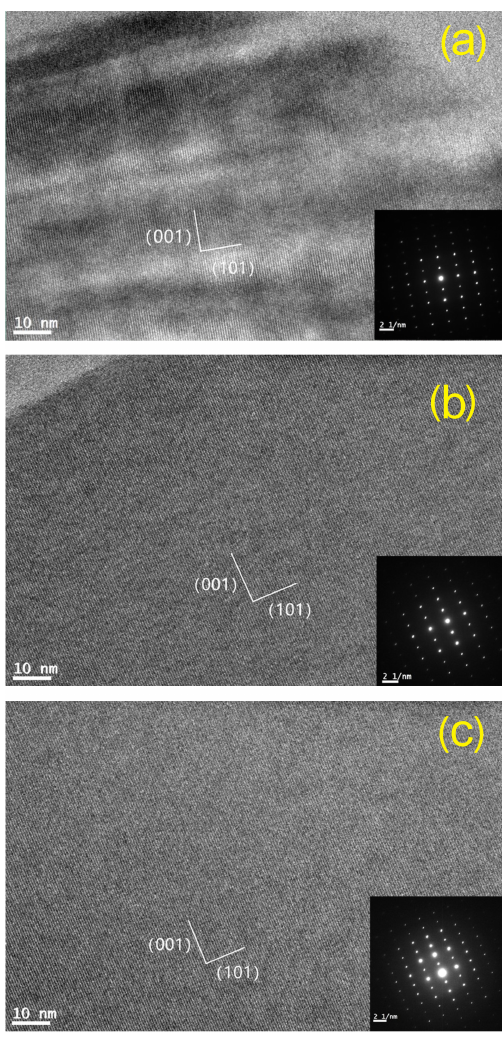
Figure 3. (a) High-resolution TEM diffractions and images of the sample no. 1, showing the wavelike lattice fringes. The heteroge- neous dark and bright parts may represent the K-rich and K-poor phases. (b) High-resolution TEM diffractions and images of sam- ple no. 2. No apparent texture effect was found. (c) High-resolution TEM diffractions and images of sample no. 3. No apparent texture effect was